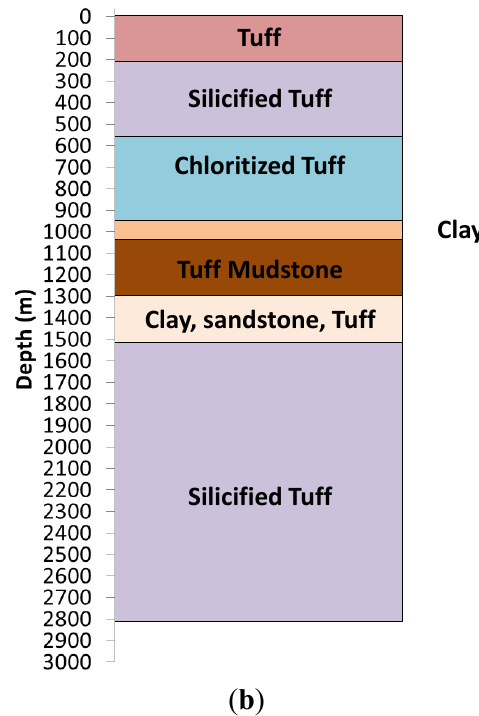
Figure 5. ( a ) Generalised lithology for well MON-1; ( b ) Generalised lithology for well MON-2 adapted from EGS Inc.